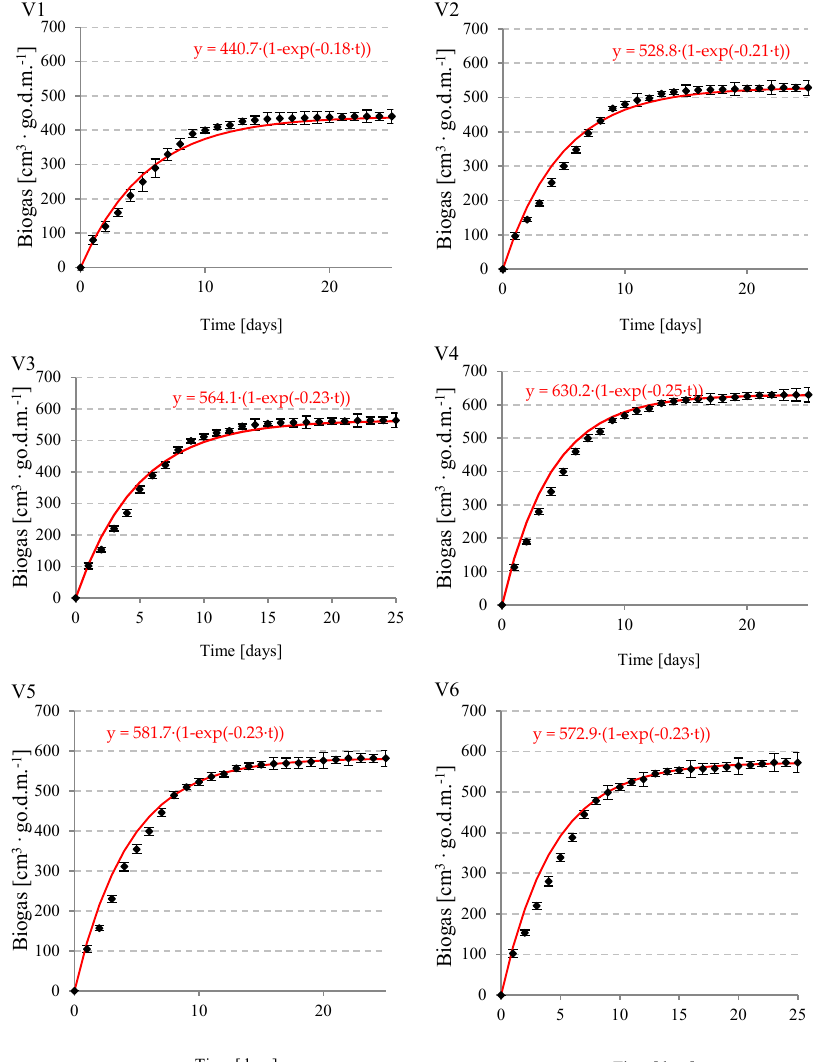
Figure 2. Effect of technological variant on biogas and methane production.